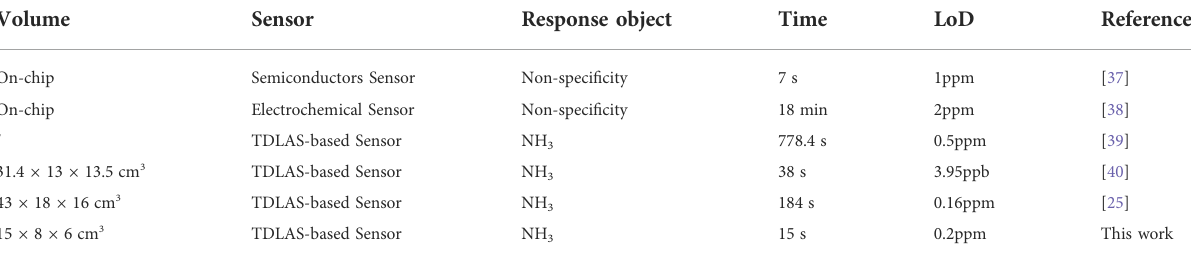
TABLE 1 Comparison of different ammonia